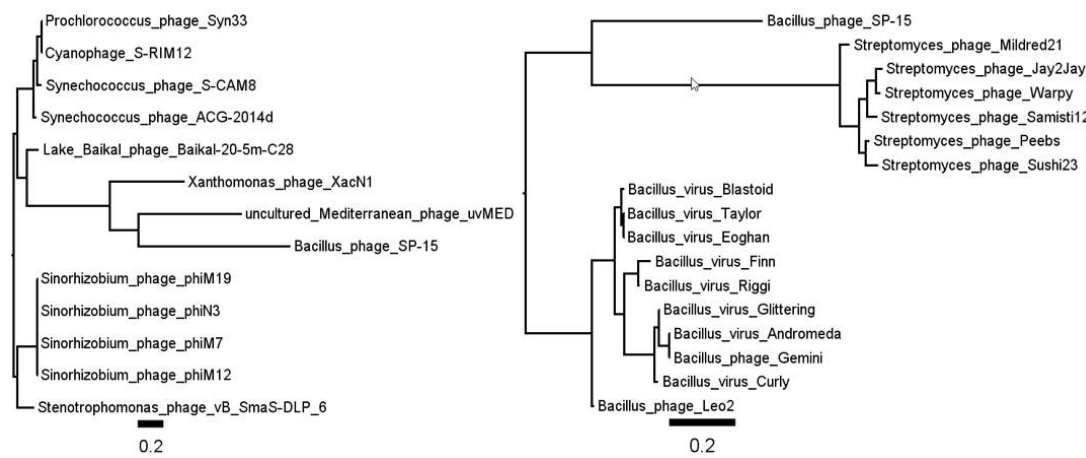
Figure 4. Phylogenetic analysis of the major capsid protein (gp34, left panel) and synthases (gp09, right panel) of Bacillus phage SP-15 reveals the former’s relationship with cyanobacterial and Sinorhizobium phage protein, while the gp09 synthase is related to an unclassified group of Streptomyces phages and Andromedavirus .